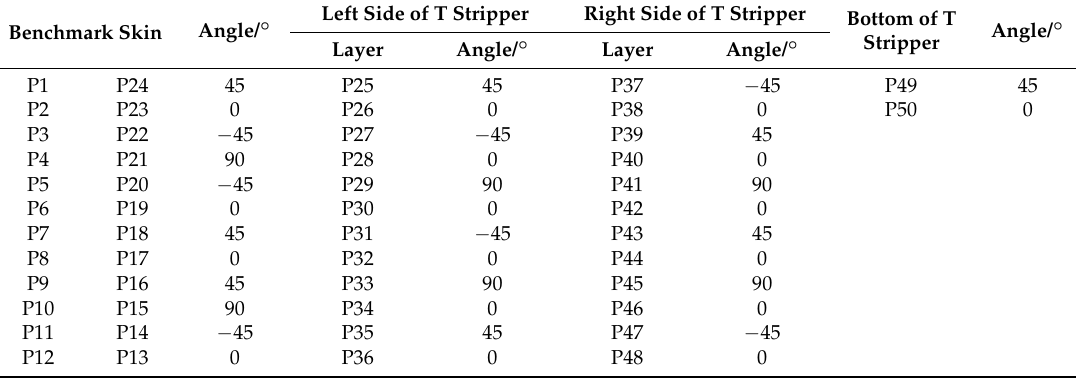
Figure 1. Cross-section of the composite reinforced panel. Table 5. Stacking sequences in each component of the composite reinforced panel.